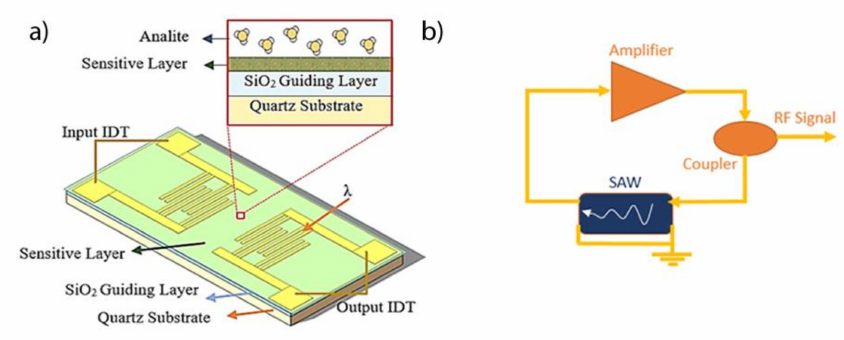
Figure 2. ( a ) Scheme representation of LW sensor and layer composition. ( b ) Oscillator circuit used to read the resonant frequency.